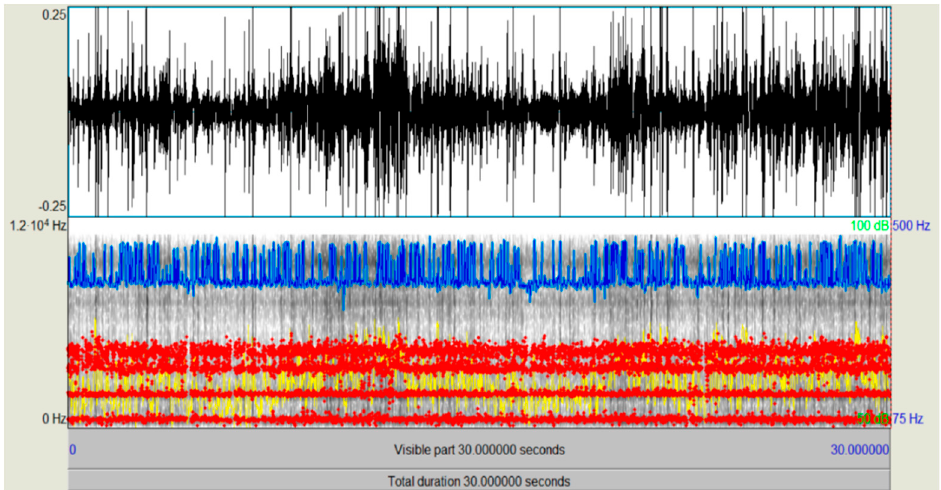
Figure 7. Spectrogram of the audio file “Cloudburst”.